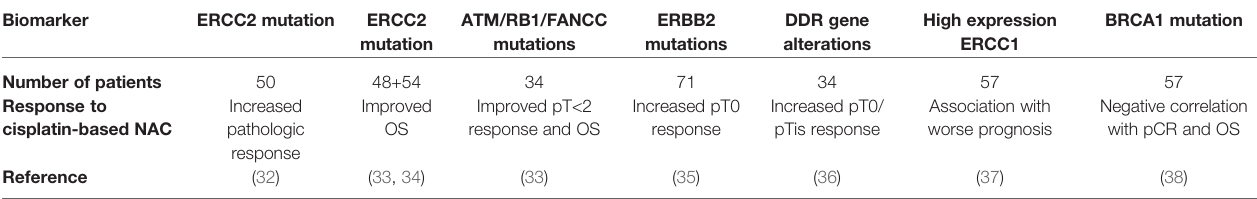
TABLE 2 | Association between biomarkers and response to NAC in MIBC. Biomarker